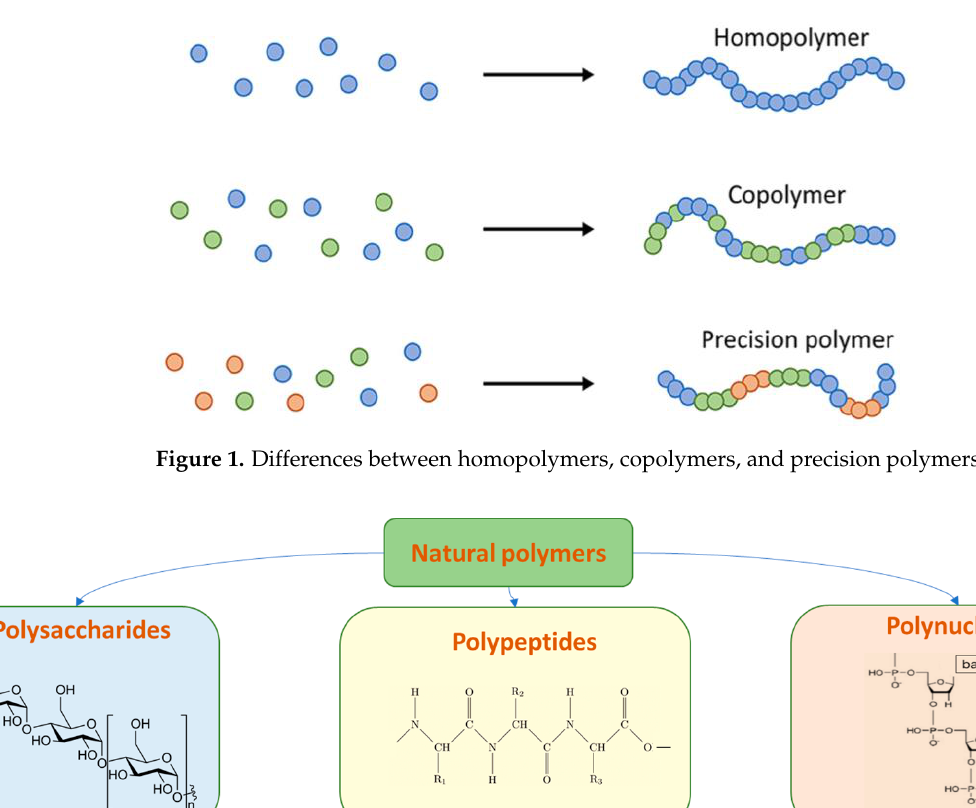
Figure 1. Differences between homopolymers, copolymers, and precision polymers.